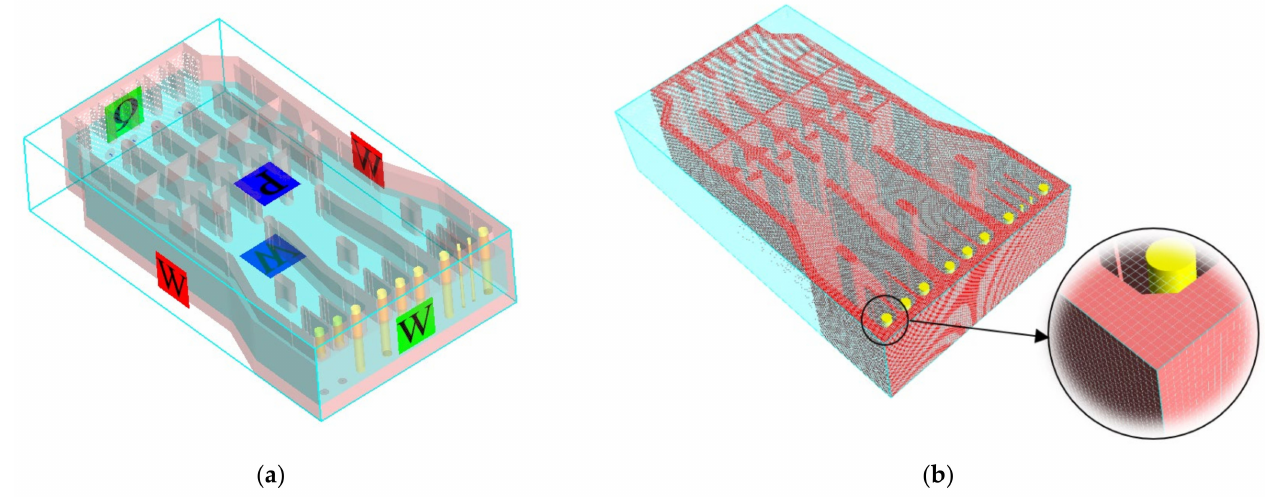
Figure 4. ( a ) Domain and boundary conditions; ( b ) Flow3D-generated orthogonal mesh associated with